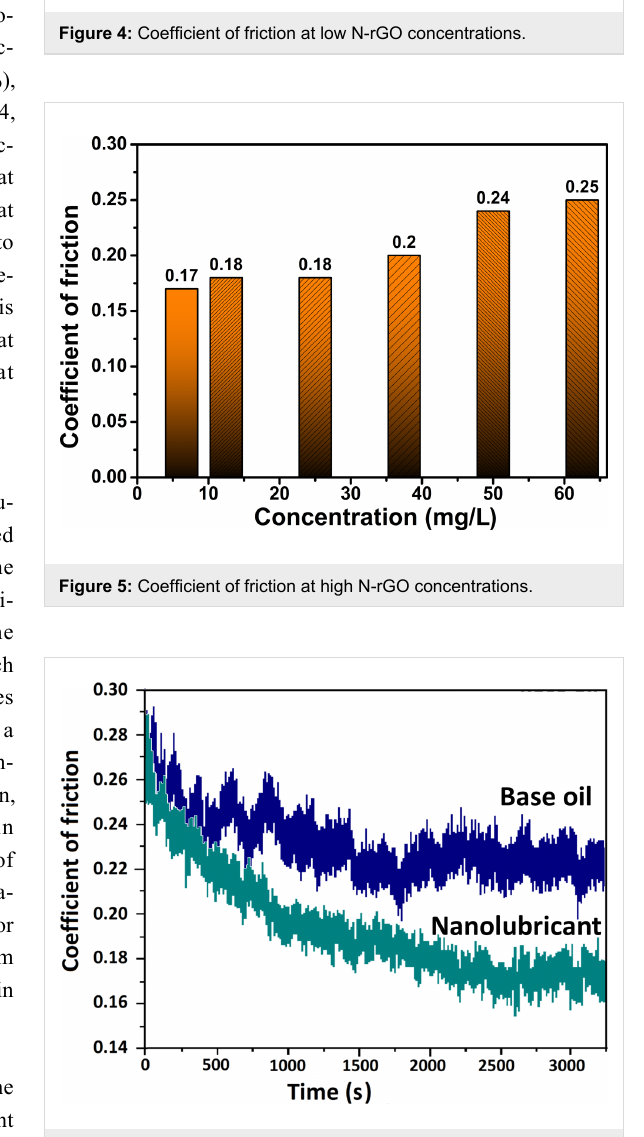
Figure 6: Variation of COF over time for base oil and nanolubricant with N-rGO (3